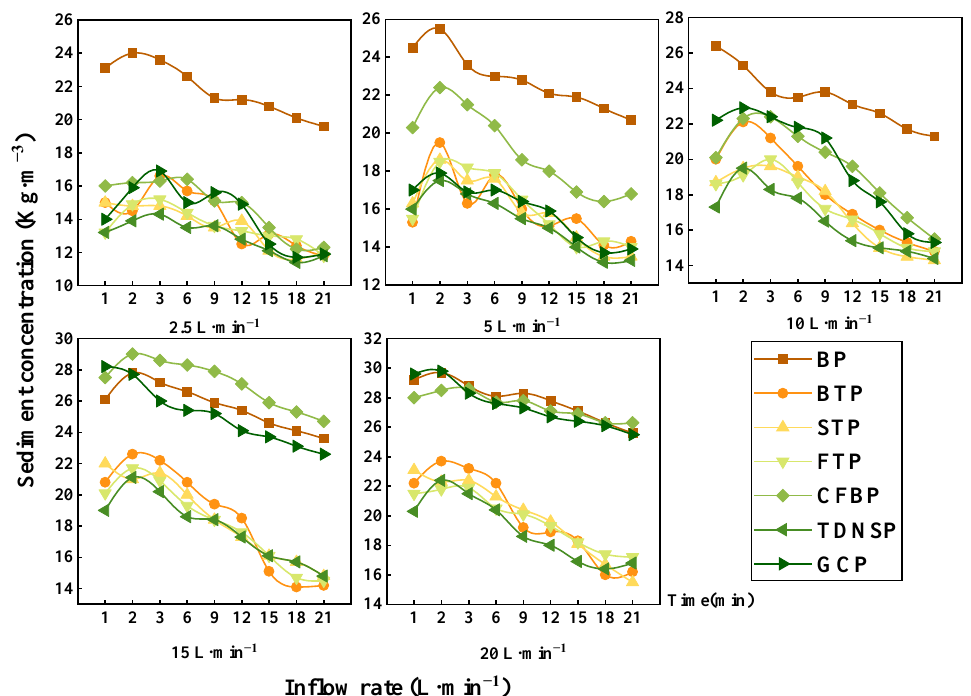
Figure 7. Sediment concentration of seven measures under different inflow times.